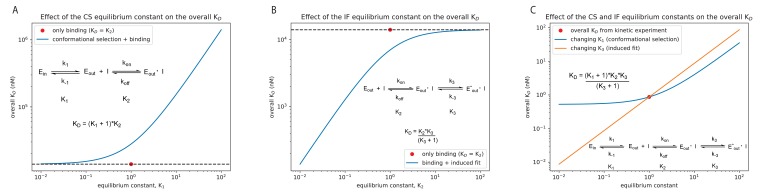
Effect of the equilibrium constant for the conformational selection and induced-fit step on the overall KD for Danusertib.The equilibrium constant was changed in both directions by two orders of magnitude starting from unity for the conformational selection (CS) mechanism (A) and induced-fit (IF) step (B). A CS step only weakens the overall affinity compared to the equilibrium constant of the physical binding step (K2; 14 μM for Danusertib, see Figure 5), whereas an IF step makes the binding tighter. (C) Effect on the overall KD for Danusertib when changing the equilibrium constants K1 and K2 by two orders of magnitude starting from their actual values (see Figure 5I).